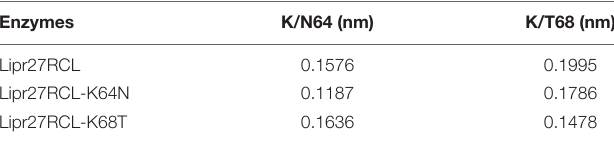
TABLE 3 | RMSF for mutated residues over the whole simulation in Lipr27RCL and two mutants.